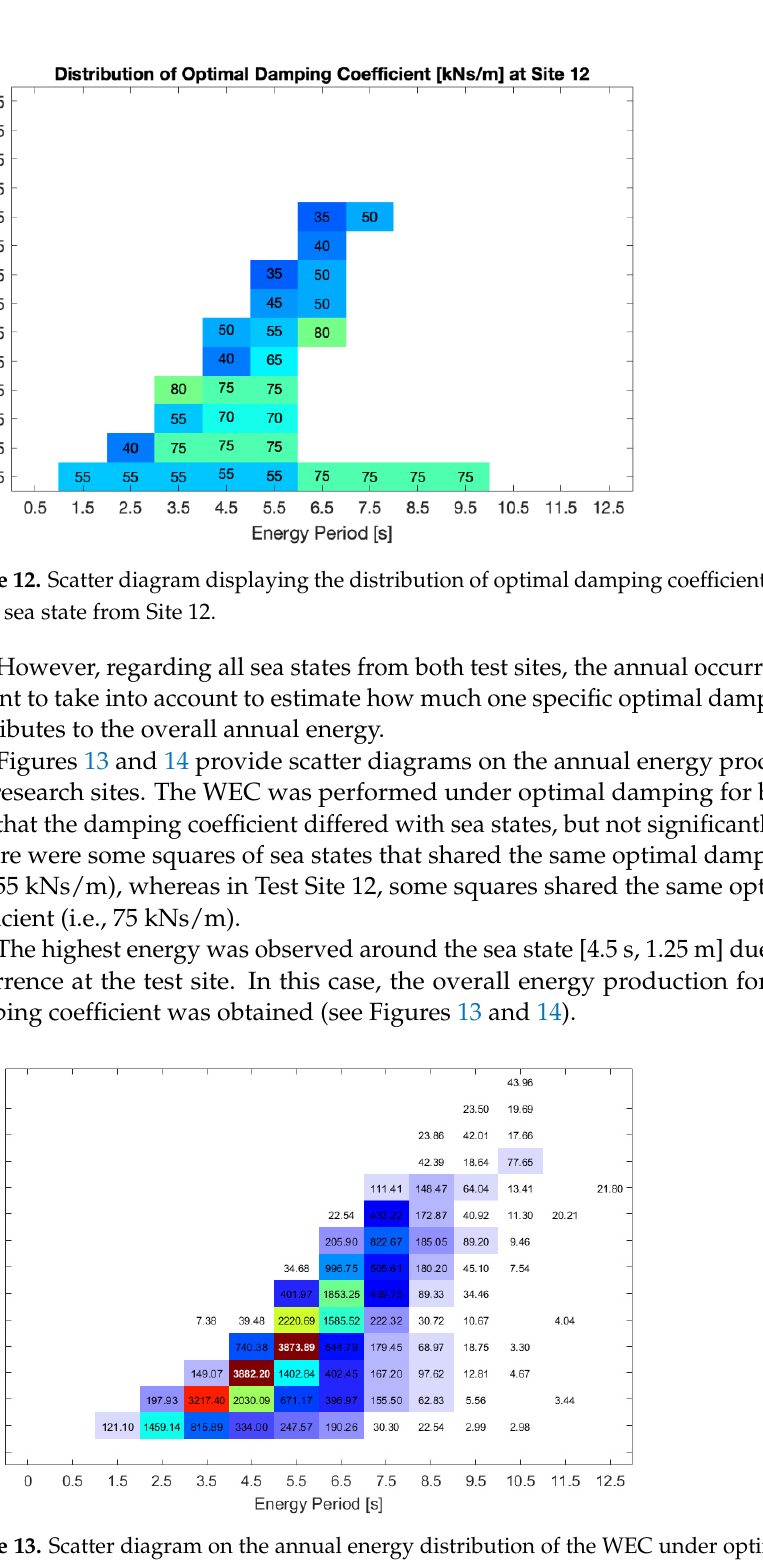
Figure 11. Scatter diagram displaying the distribution of optimal damping coefficients corre- sponding to the sea state from Site 1.